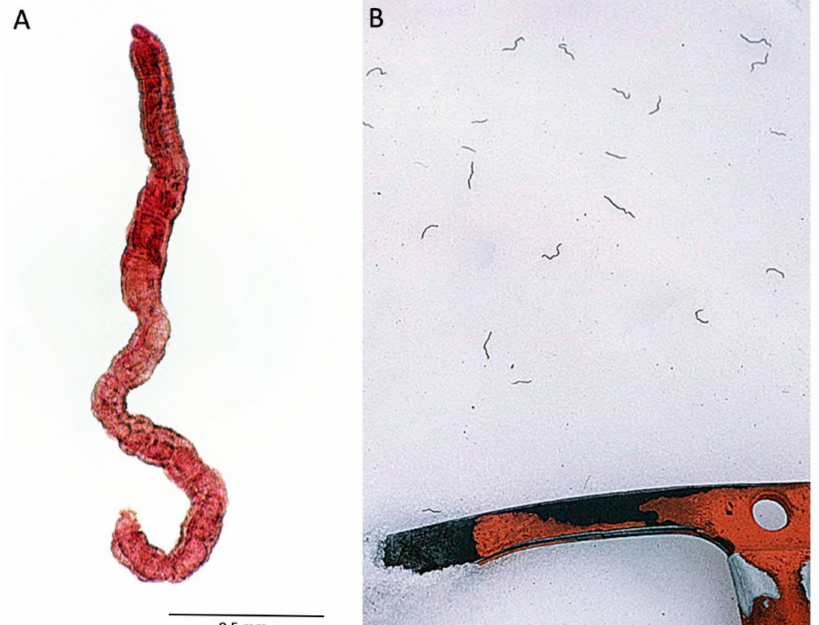
Figure 3. ( A ) Aktedrilus yacoubii (Phallodrilinae, Naididae), a stygobiotic oligochaete species from a resurgence in Morocco, illustrated as a freshwater representative of a mainly marine subfamily. Photograph: P. Martin. ( B ) The highly-pigmented aquatic “ice worms”, Mesenchytraeus solifugus, live in the melted ice cracks of North-American glaciers, tolerating only a narrow ± 7 ◦ C range near freezing. Photograph: Dick Culbert, Stikine Icecap between Alaska and British Columbia; image cropped, otherwise unmodified, licensed under